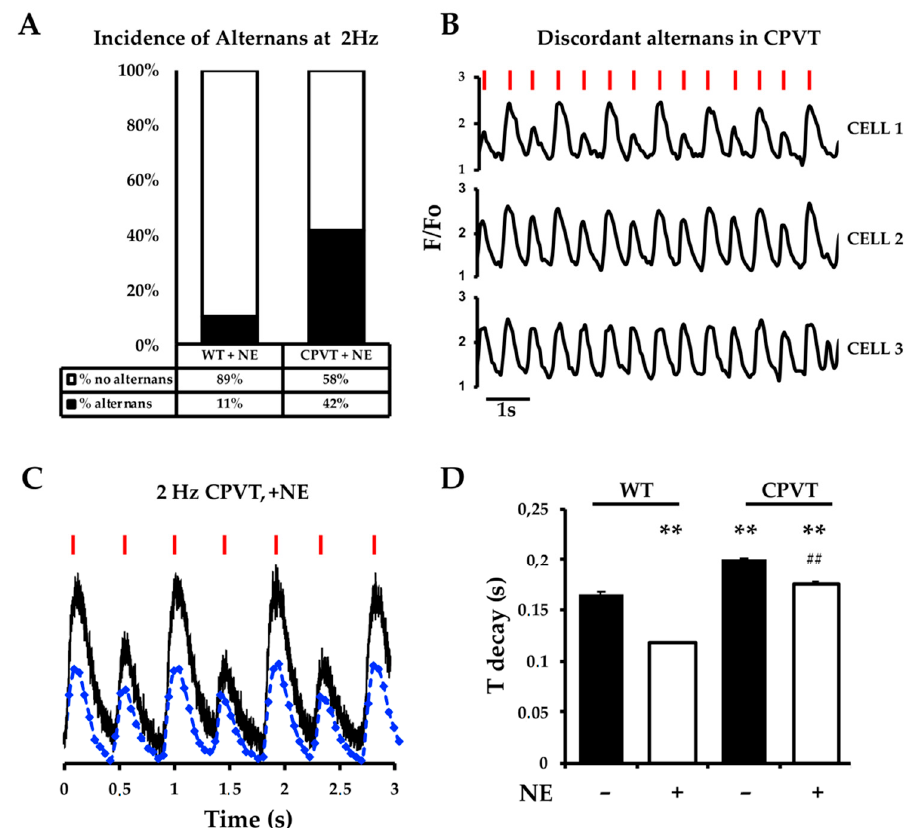
Figure 3. CPVT heart slices develop Ca 2+ alternans upon β -AR stimulation. ( A ) Fraction of cells developing Ca 2+ alternans in WT and RyR2 RS/wt slices, paced at 2 Hz, during β -AR stimulation with NE (1 µ M). ( B ) Representative plots of Ca 2+ oscillations in three adjacent CMs in a RyR2 RS/wt slice upon NE perfusion, showing alternans synchronous in phase, but not in amplitude (red bars indicate electrical pacing). ( C ) Line scan profiles from CPVT CMs, in basal (blue line) or NE-stimulated (black line) conditions, during 2 Hz stimulation. ( D ) Decay time of Ca 2+ transients calculated on the line scan profiles in ( C ), for both WT and CPVT slices, paced at 2 Hz. Error bars represent SD ( n = 25 cells/condition; ** p < 0.01 compared to WT; ## p < 0.01 compared to CPVT in basal condition).